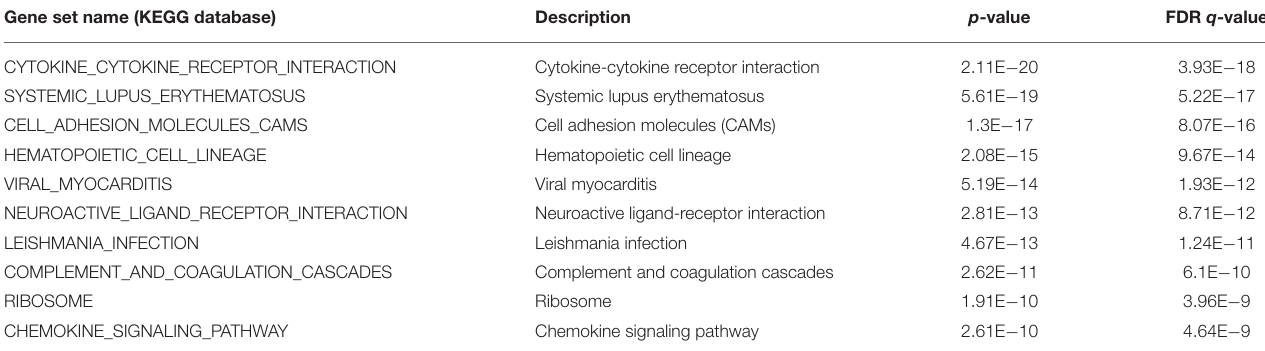
TABLE 1 | Top 10 C2 curated gene sets (KEGG Database) significantly enriched in human